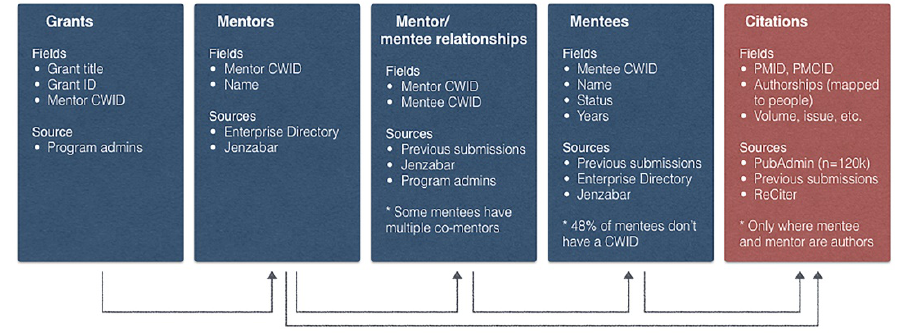
Figure 2 Data flow for generating T32 grant